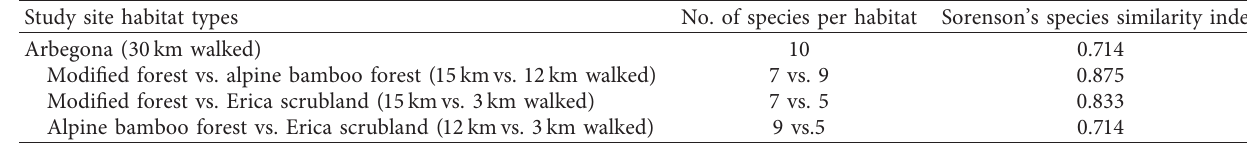
Table 3: Sorensen species similarity index for the large wild mammals among different habitat types of Geremba Mountain, southern Ethiopia.